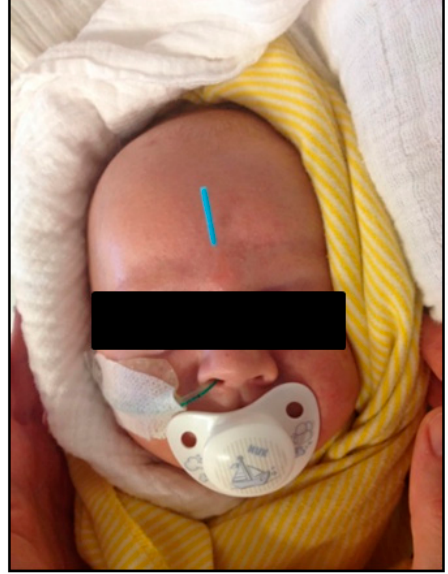
Figure 1. Sleeping baby with a needle positioned at Yin Tang.